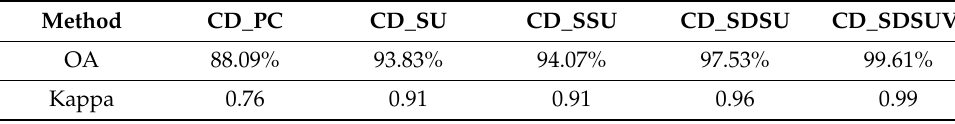
Table 3. The accuracy statistics for the simulated data.